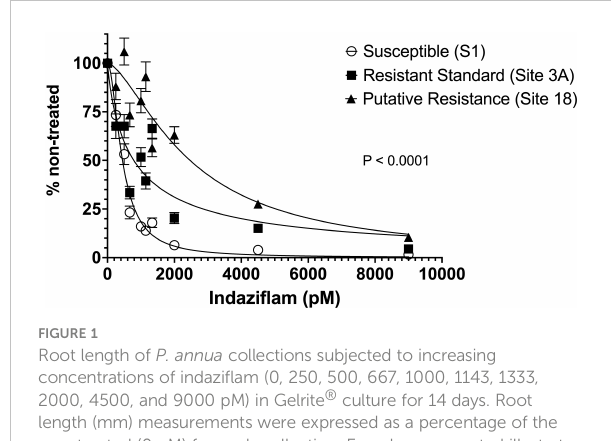
FIGURE 1 Root length of P. annua collections subjected to increasing concentrations of indazi fl am (0, 250, 500, 667, 1000, 1143, 1333, 2000, 4500, and 9000 pM) in Gelrite ® culture for 14 days. Root length (mm) measurements were expressed as a percentage of the non-treated (0 pM) for each collection. Error bars presented illustrate the standard error of the mean for each collection (N = 150).